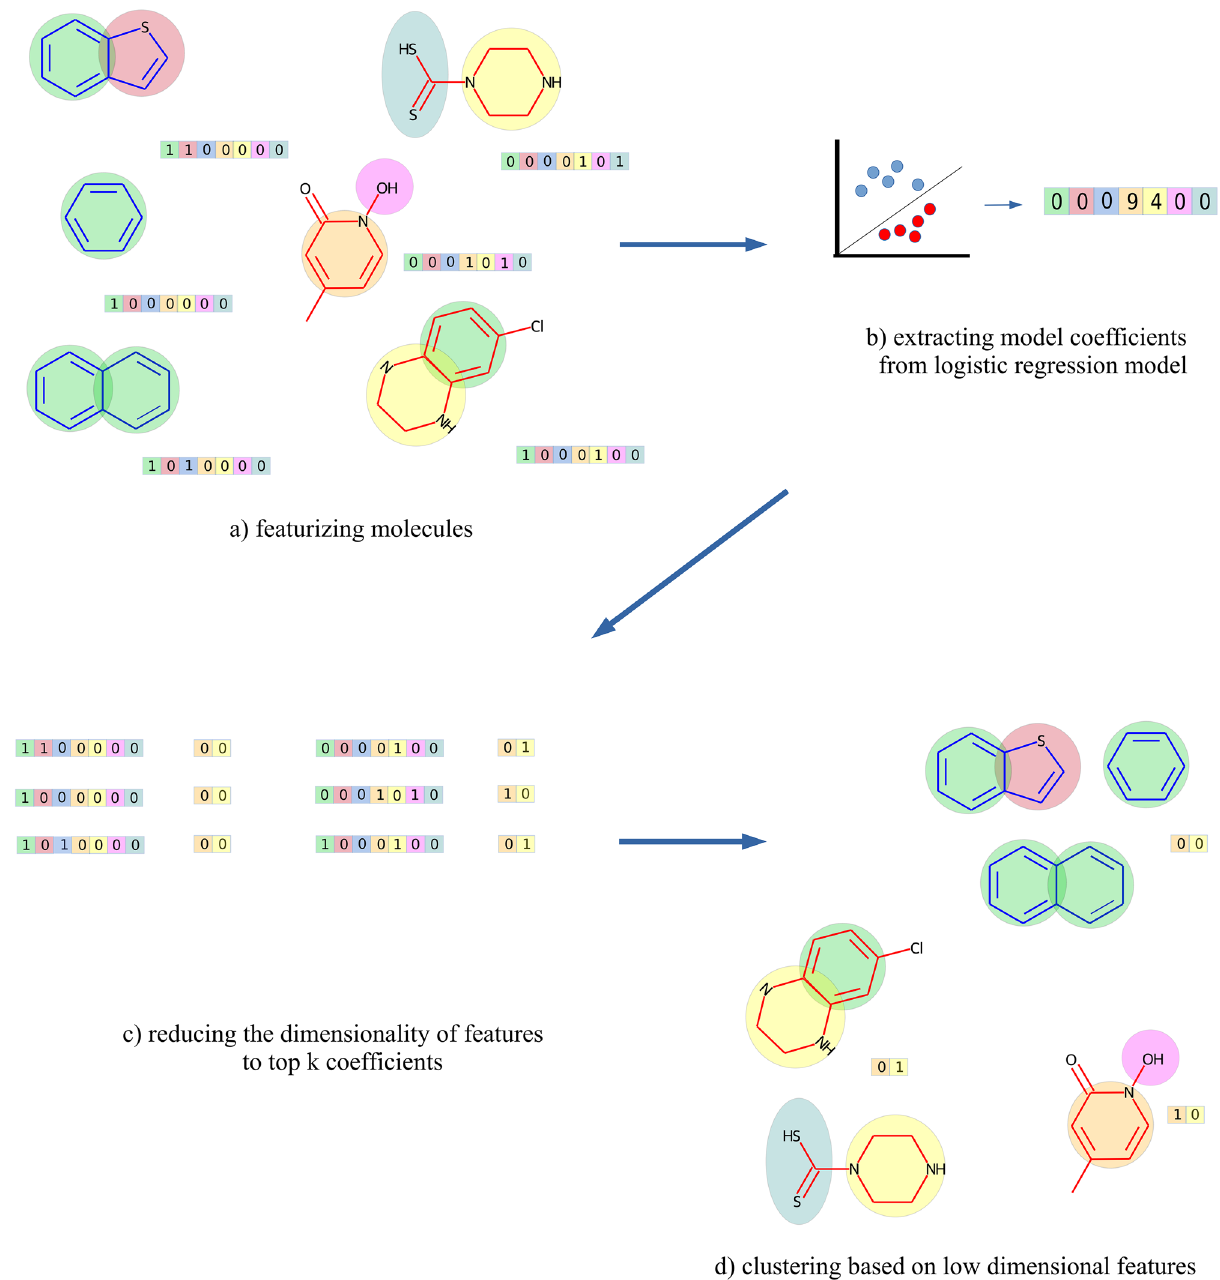
Figure 2. Clustering molecules based on their mechanism of action. Given ( a ) a collection of molecules, MOACluster extracts their binary features. Then ( b ) a logistic regression classifier is trained on the resulting binary features and the model coefficients are extracted. ( c ) MOACluster finds the indices of the top k coefficients and reduces molecule binary features to those k indices. ( d ) The molecules are clustered according to the reduced binary